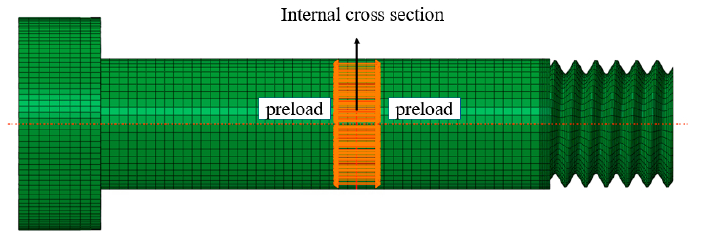
Figure 10. Schematic diagram of bolt preload.